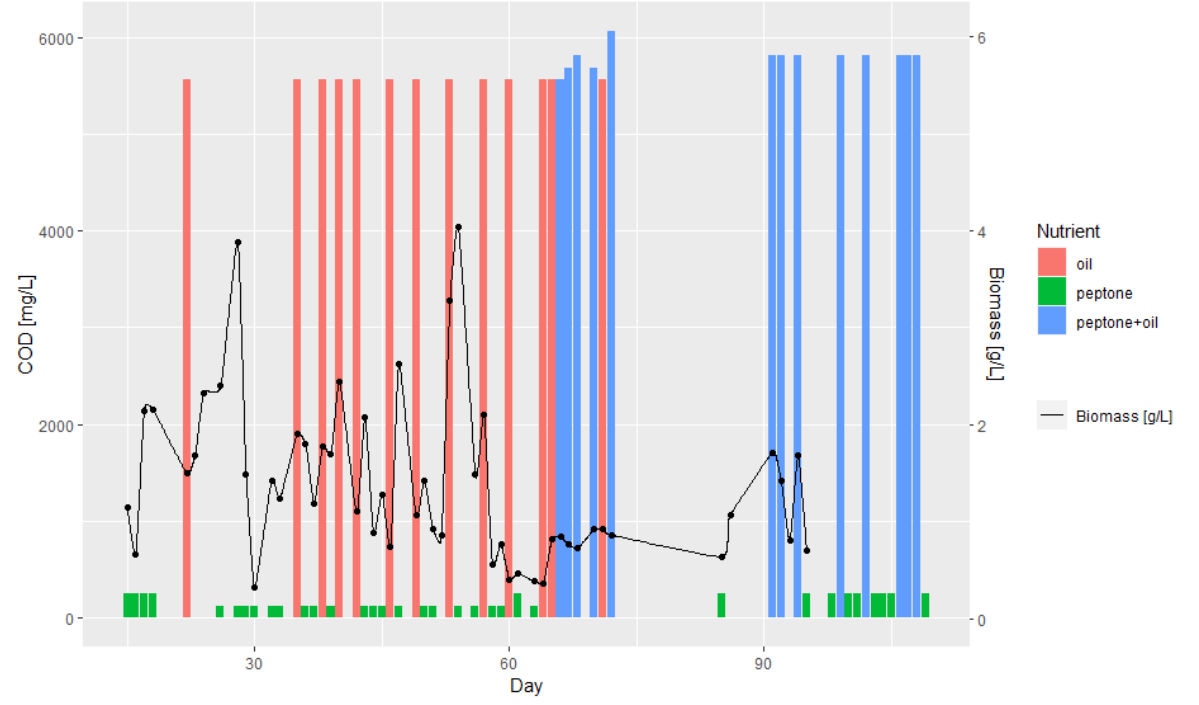
Figure 5. Relationship in time between chemical oxygen demand, nutrient medium, and unfiltered sample from the batch bioreactor.